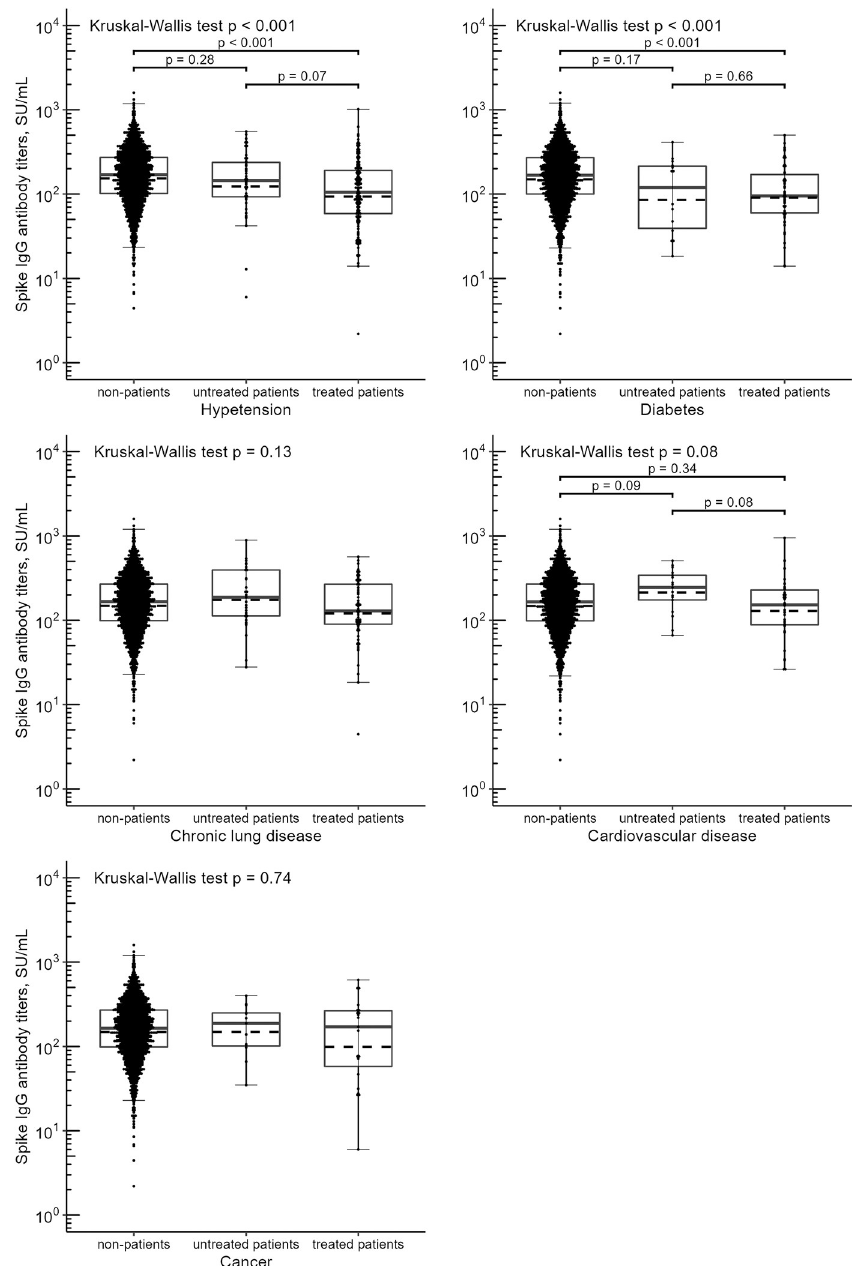
Fig 1. Anti-SARS-CoV-2 spike IgG antibody titer distributions according to the presence or absence of chronic diseases and treatments. The solid line in boxes represents the first quartile, the median value, and the third quartile. The dashed line represents the geometric mean value. The whiskers extend to the most extreme data point, which is no more than 1.5 times the length of interquartile range away from the box. Each black point represents an individual sample. Difference between the median of antibody titers was analyzed using the Kruskal-Wallis test. The Dunn’s procedure adjusted by the Holm method was used for multiple comparisons when the null hypothesis of the Kruskal- Wallis test was